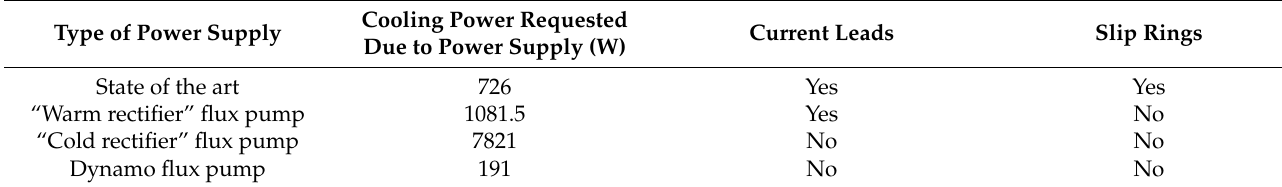
Table 5. Power supplies comparison for the EcoSwing wind turbine field